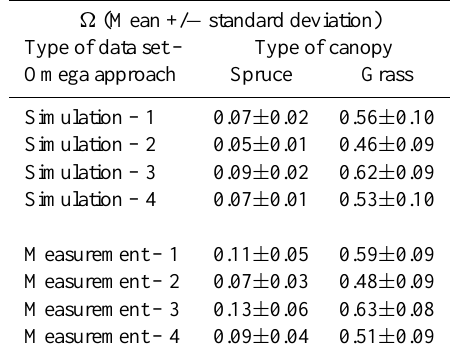
Table 3. Mean values (based on half-hour means between 09:00 and 16:00LT) and standard deviation of the omega approaches ac- cording to Eqs. (1) to (4). Comparison between measurements and simulation in the period from 18 to 21 June